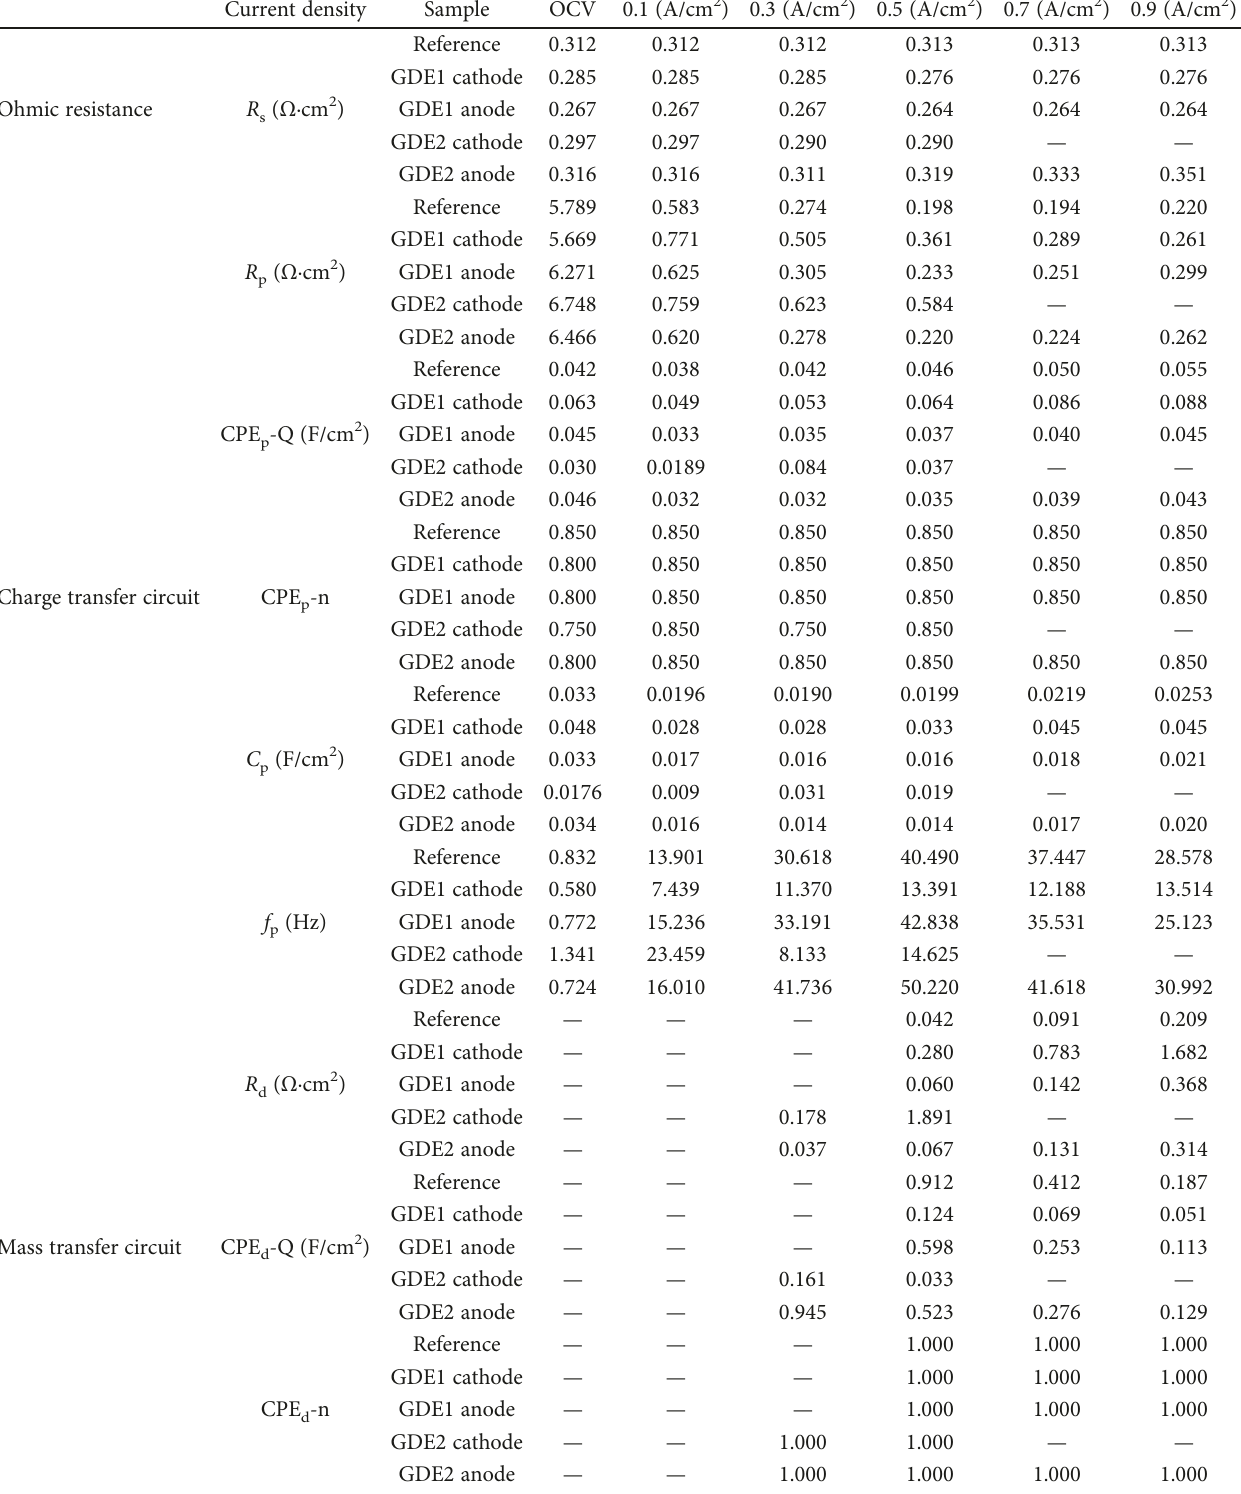
Table 2: The fi tting parameters for the impedance spectra at di ff erent current densities (i.e., from OCV to 0.9A · cm − 2 ) and low inlet gas fl ow rates (H /air: 0.2/1 2